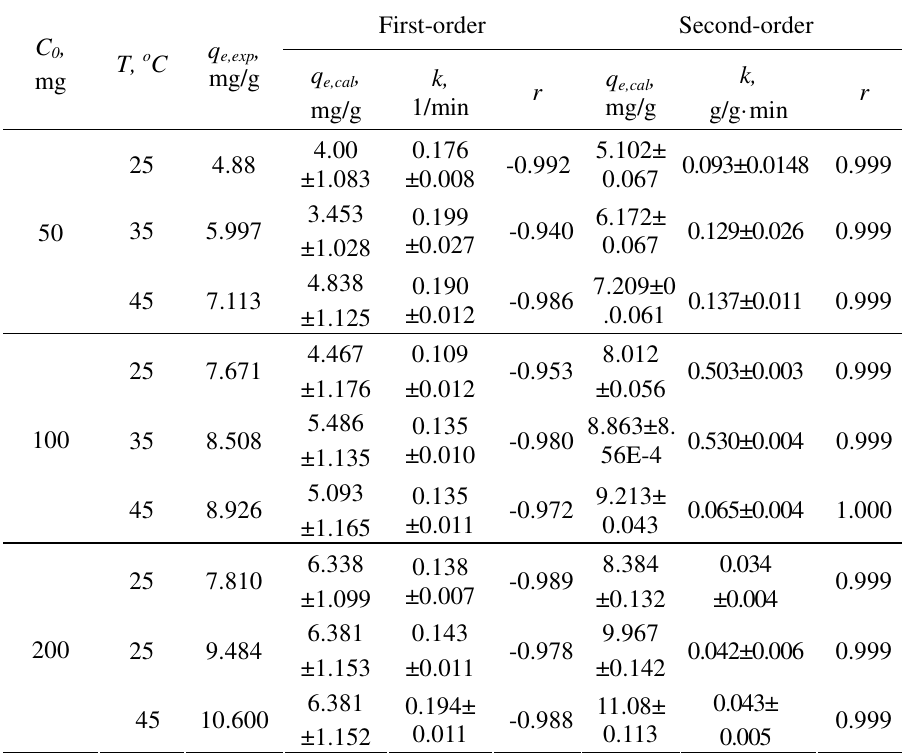
Table 5 . Comparison of the adsorption kinetic models of PVA (500) on